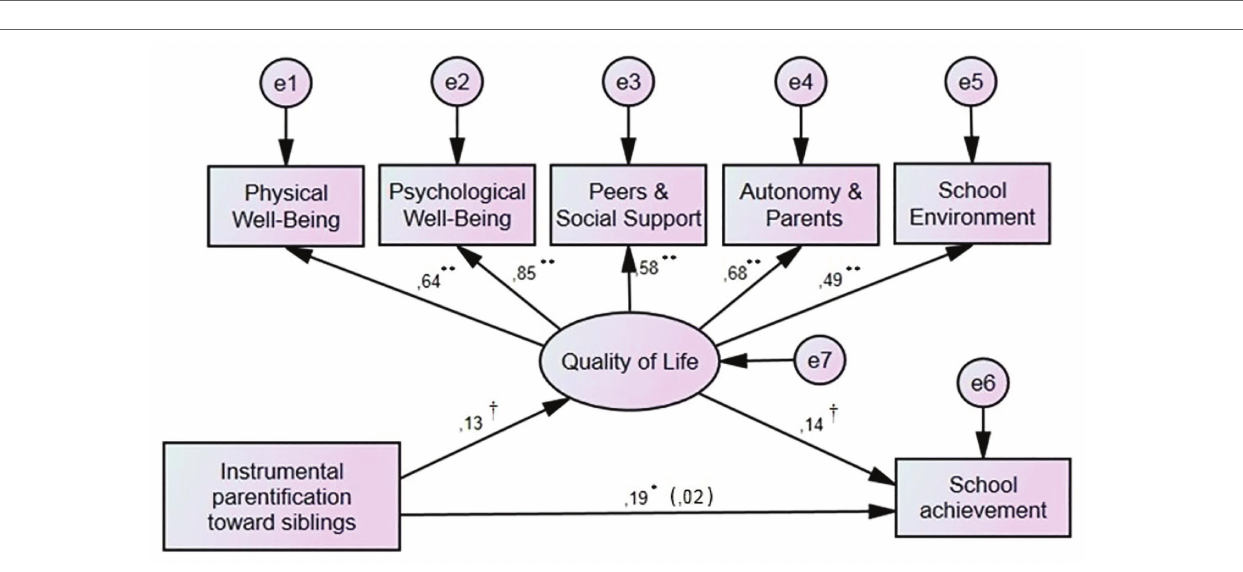
FIGURE 1 | The mediating effect of quality of life on the relation between instrumental parentification toward parents and school achievement. * p < 0.05; ** p < 0.01.